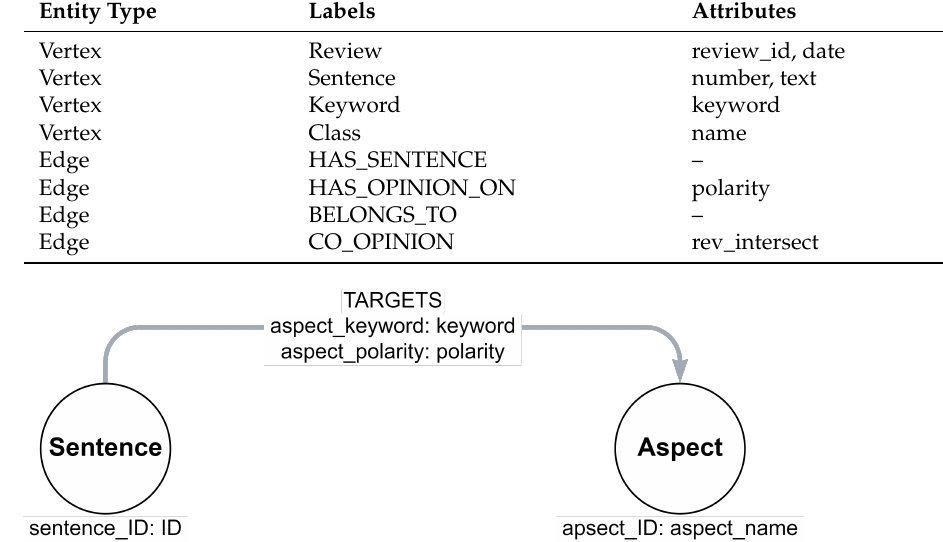
Figure 3. Sentence-aspect bipartite labeled property graph.